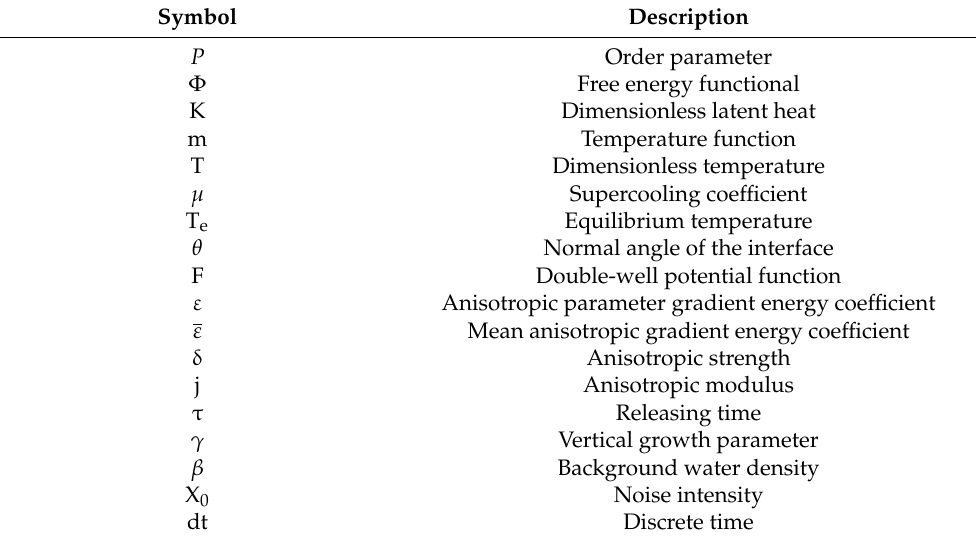
Table A1. Symbol